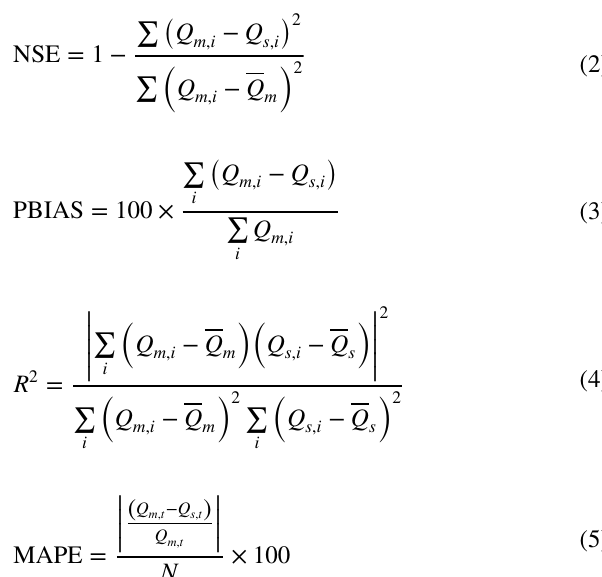
sensitivity analysis, it can be observed that SWAT model is sensitivity to two parameters of each snow-cover, channel flow paths and soil charac-